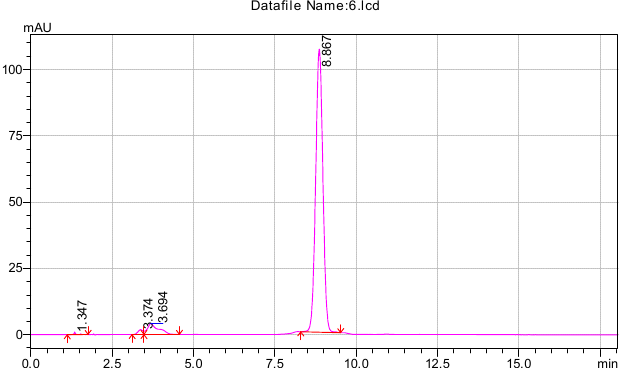
Figure 2. The content of impurity X detected by HPLC.